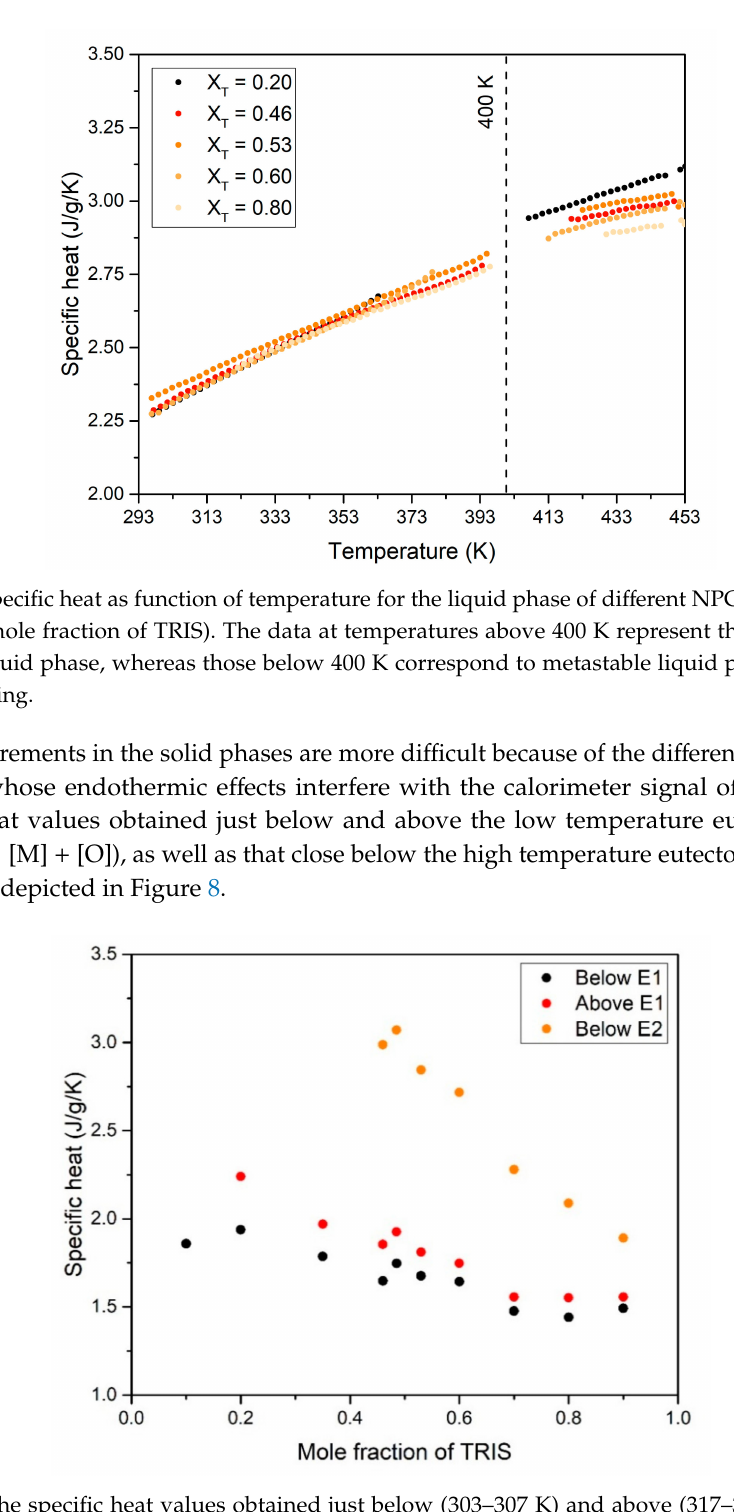
Figure 8. The specific heat values obtained just below (303–307 K) and above (317–321 K) the low temperature eutectoid (E1), as well as that close below (362–363 K) the high temperature eutectoid